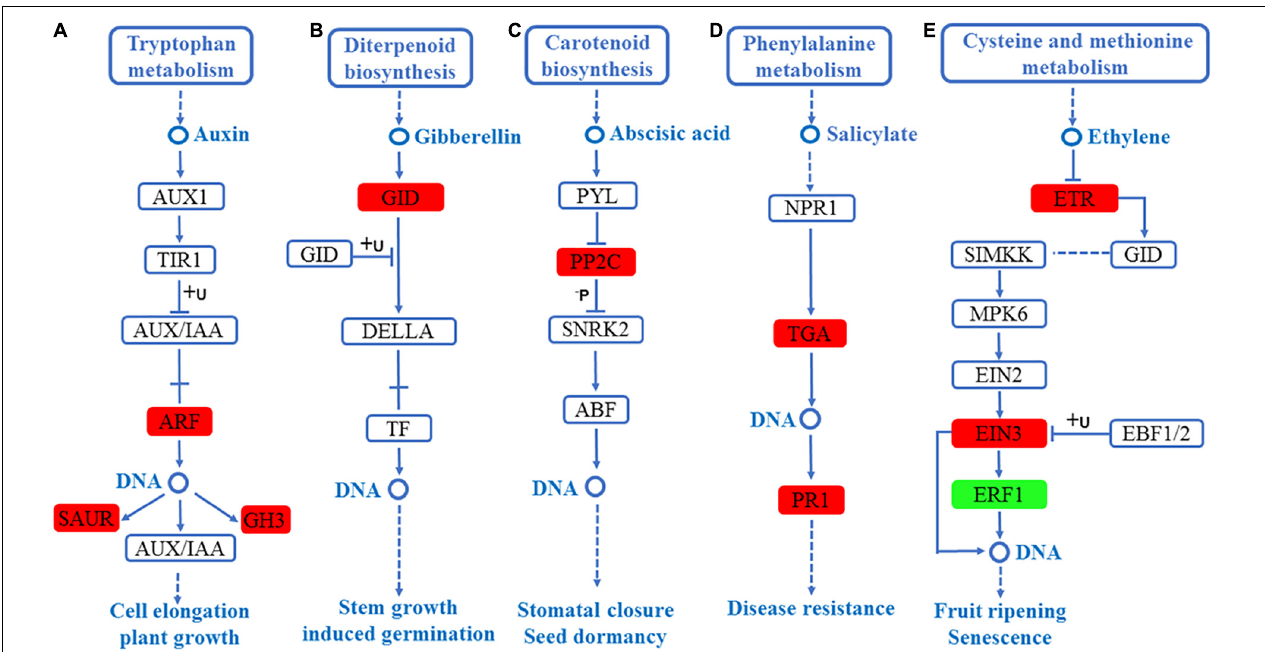
FIGURE 7 | DEGs mapped to the plant hormone signaling transduction pathways in the leaves of S. argel plants under salt stress conditions. (A) Auxin signaling pathway, (B) gibberellin signaling pathway, (C) ABA signaling pathway, (D) salicylate signaling pathway, and (E) ethylene signaling pathway. The red box r indicates up-regulated pathway compared with the control. At the same time, the green box indicates down-regulated pathway compared with the control. The fold change (FC) and P -value ≤ 0.05 are shown in Table 3